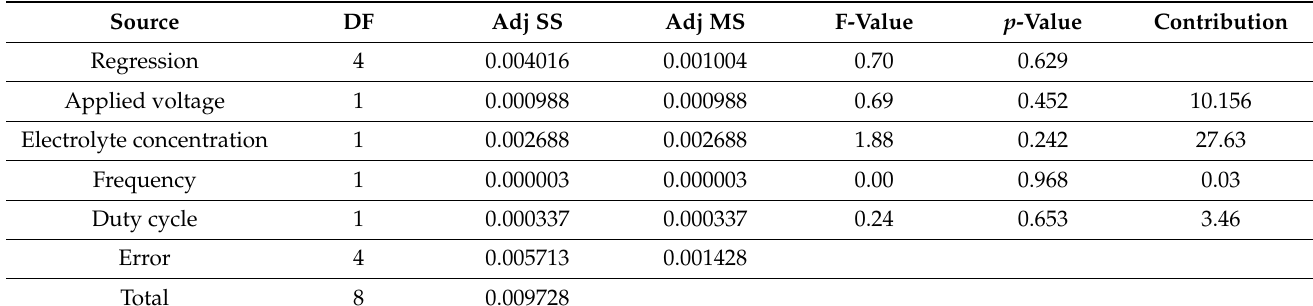
Table 11. ANOVA for circularity for quenched tool.